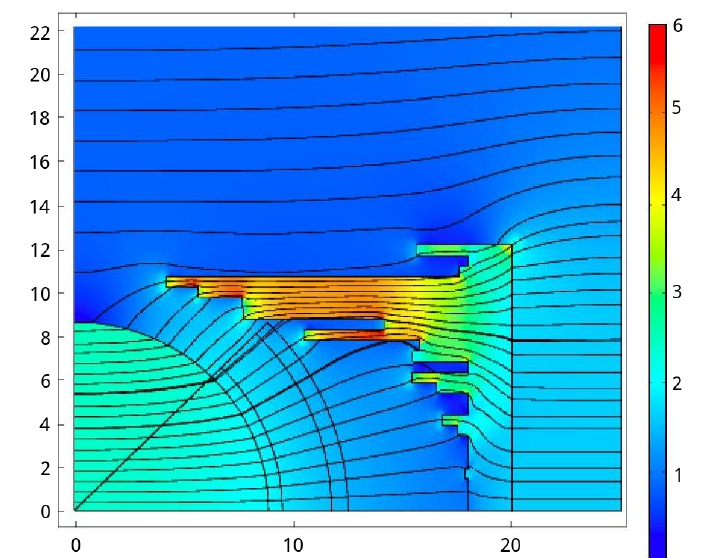
Figure 5. Optimal design using a commercial software— R 1 parameter is also